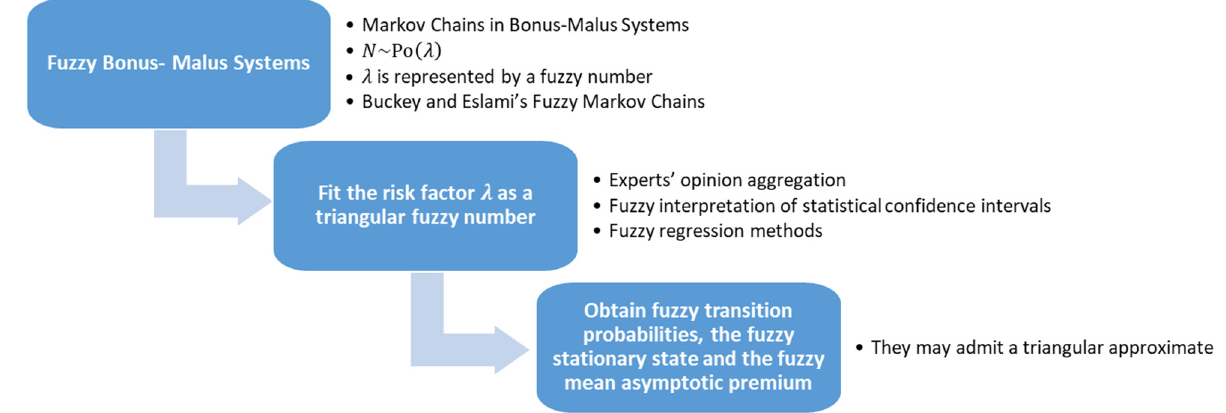
Figure 1. Graphical representation of our fuzzy bonus-malus systems (FBMS) model.